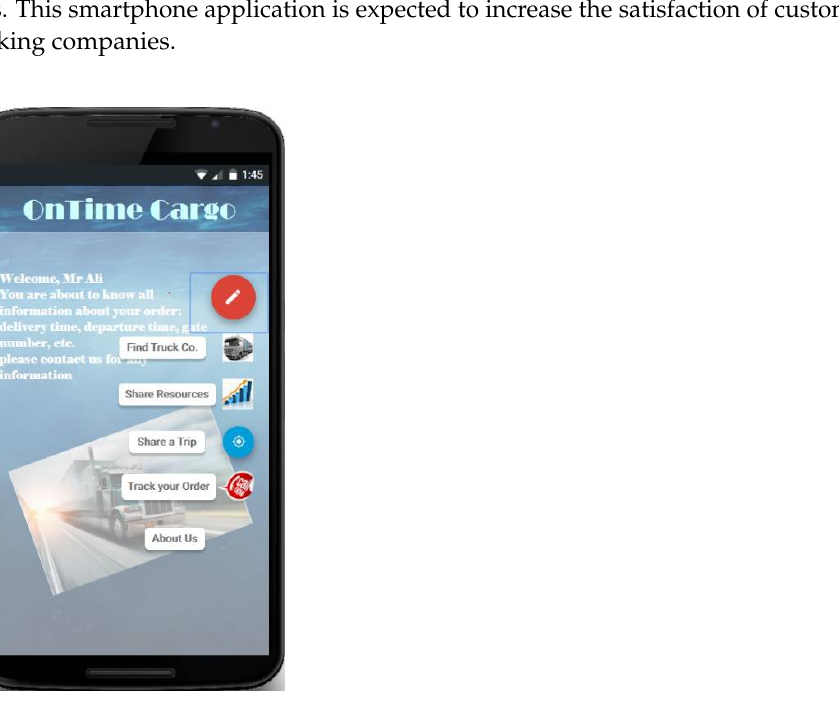
Figure 9. Appearance prototype of the proposed smartphone-based system for cargo transporta- tion.